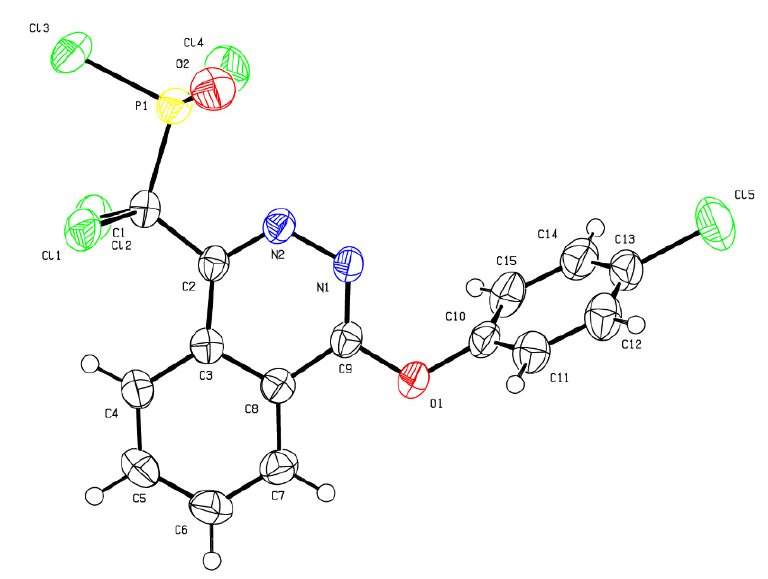
Figure 3. X-ray crystallography structure of compound 3 .